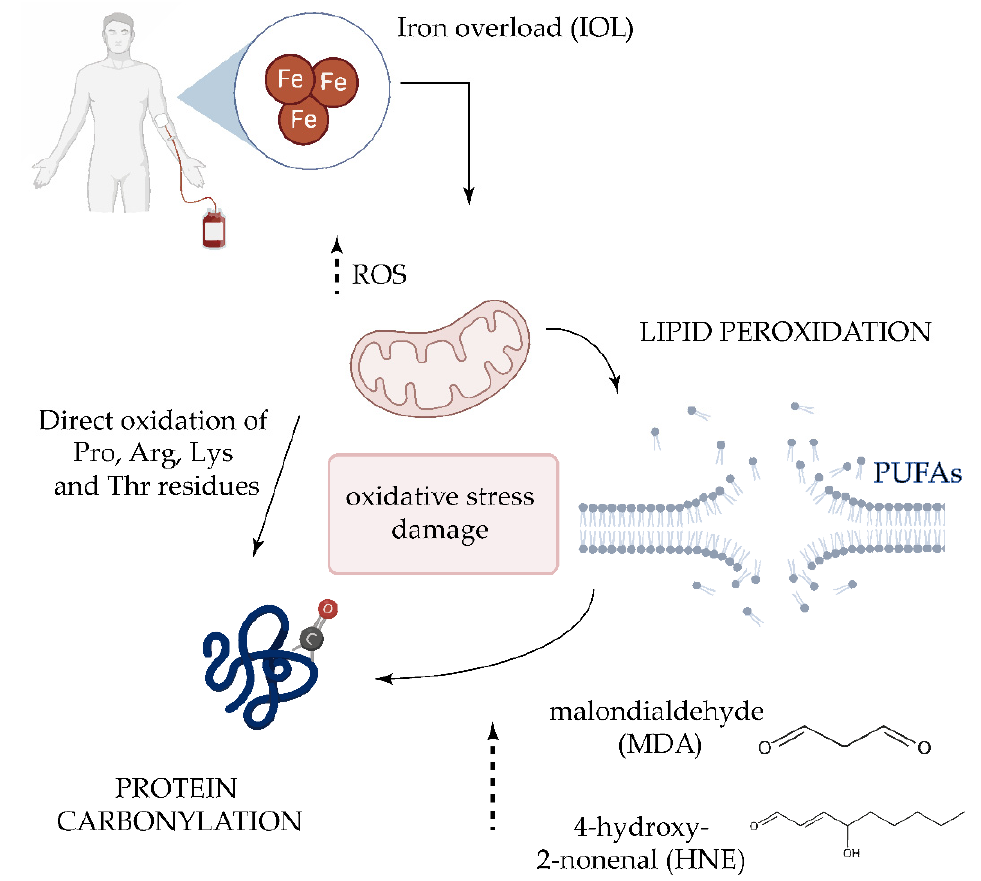
Figure 3. Oxidative damage in transfusion-dependent patients with MDS. Frequent transfusions in patients with MDS leads to iron overload in serum, which plays a key role in the generation of highly reactive oxygen species (ROS) [135]. The increase of ROS could directly oxidize proline (Pro), Arginine (Arg), Lysine (Lys), and Threonine (Thr) residues. ROS-induced lipid peroxidation of long-chain polyunsaturated fatty acids (PUFAs) also promotes protein carbonylation by reaction with lipid peroxidation end-products such as malondialdehyde (MDA) and 4-hydroxy-2-nonenal